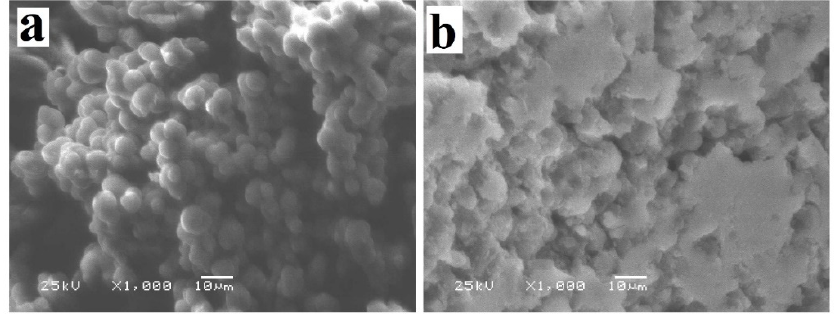
Figure 6. SEM micrographs of ( a ) CQVP/MA and ( b ) CQVP/MA-Fe 3 O 4 .